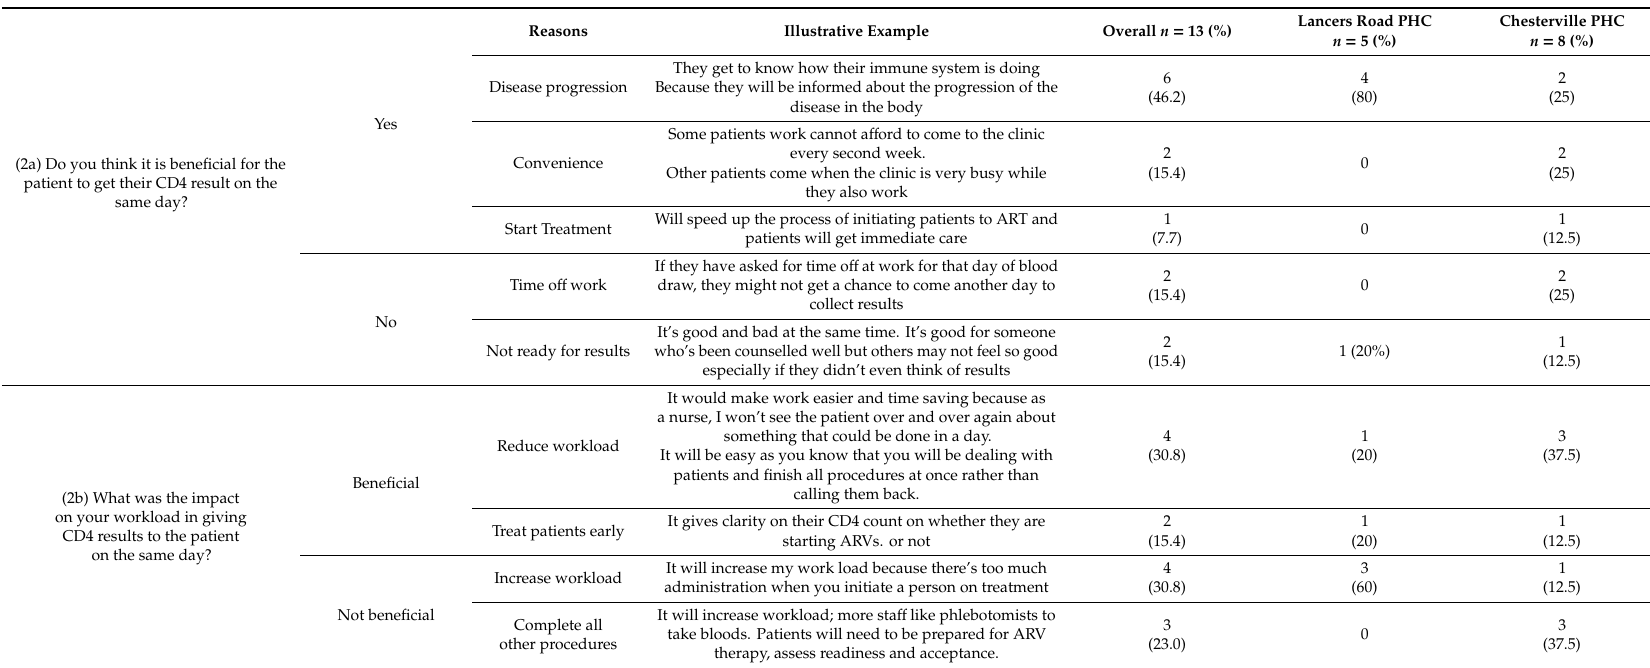
Table 2. Nurses’ understanding and perceptions of the impact of a POC laboratory provision of CD4 test results at the PHC facility with respect to patient workload, clinical management, and antiretroviral therapy (ART) administration /